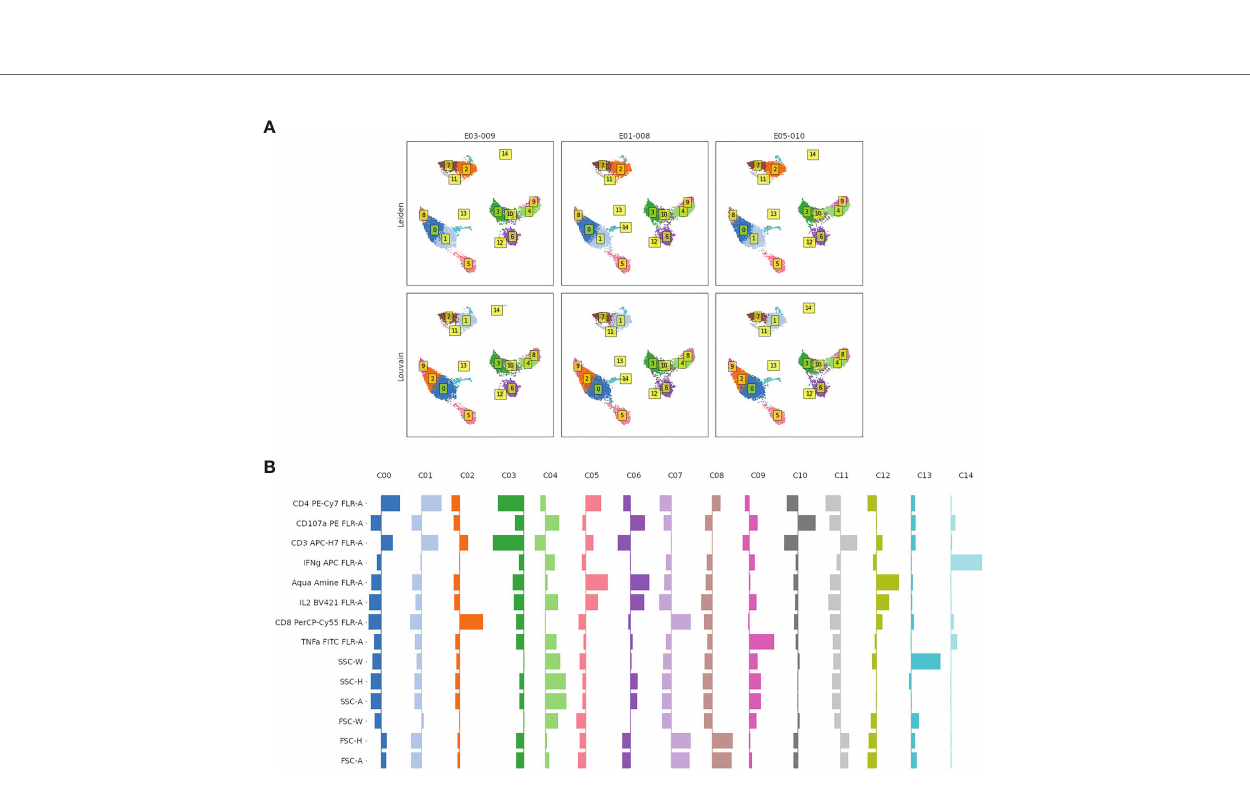
FIGURE 4 | (A) Comparison of the Leiden and Louvain community detection algorithms for clustering fl ow cytometry data. Labels in boxes are the assigned cluster indexes. Events plotted using PaCMAP for dimension reduction and colored according to the event cluster label. (B) Visualization of marker distribution for each cluster found using the Leiden algorithm shown in the top panel. Distributions are for values scaled to have zero mean and unit standard deviation; values to the left (right) of the thin vertical indicate mean marker values for that cluster that are below (above) the average for all